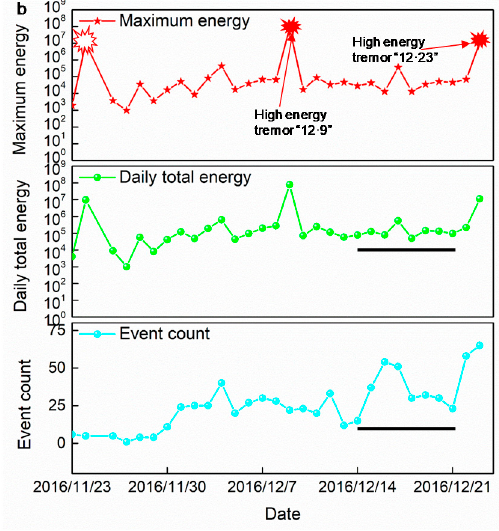
Energies 2021 , 14 , 1186 12 of 29